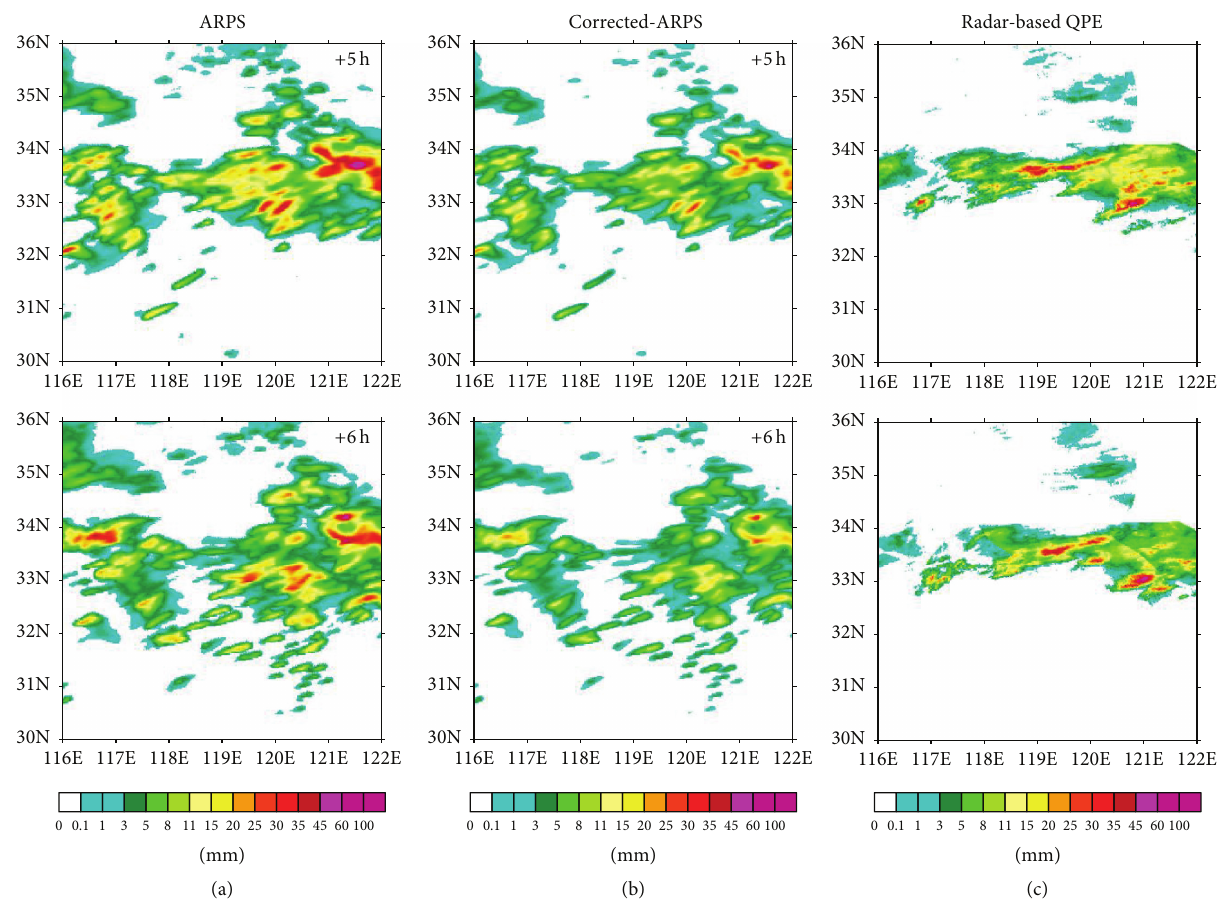
Figure 3: Comparison of forecasted precipitation by the original (a) and corrected (b) ARPS initialized at 1500 BJT on 24 June 2015 from 1h to 6 h lead times with corresponding radar observations